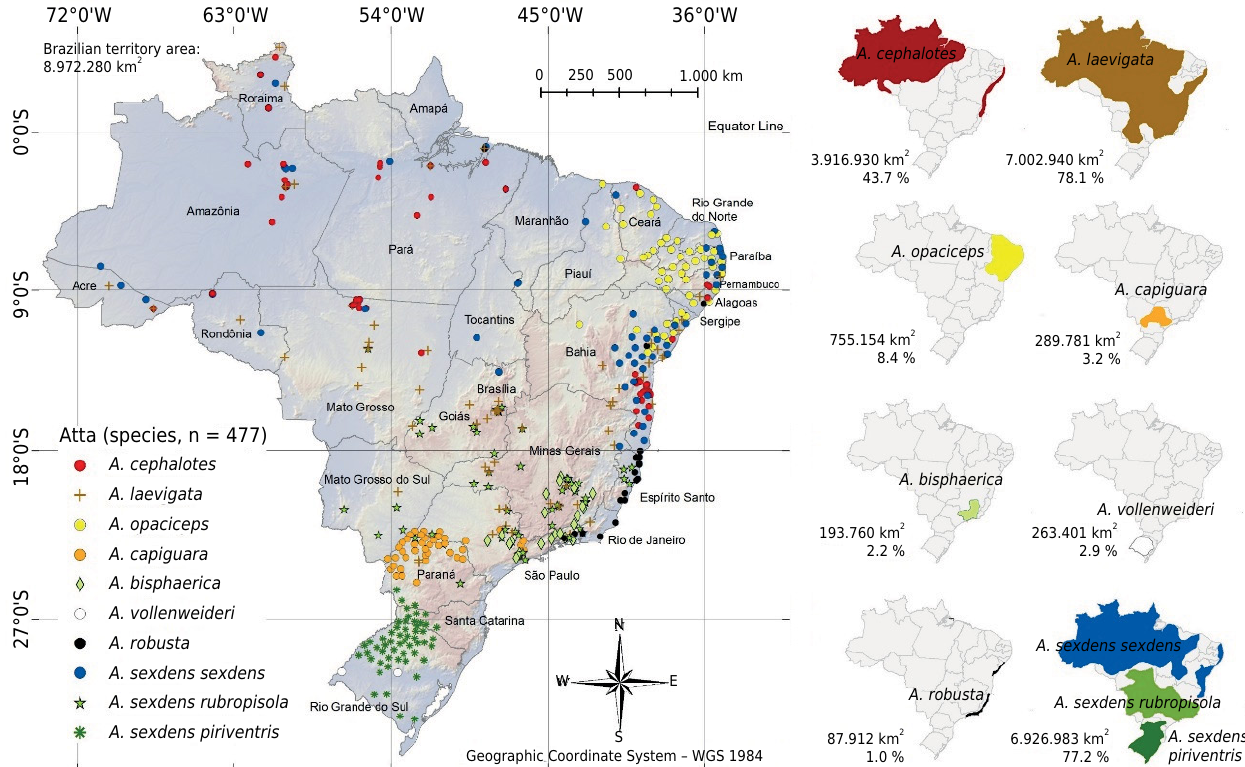
Figure 1. The genus Atta (Formicidae: Attini) spatial distribution at Brazilian